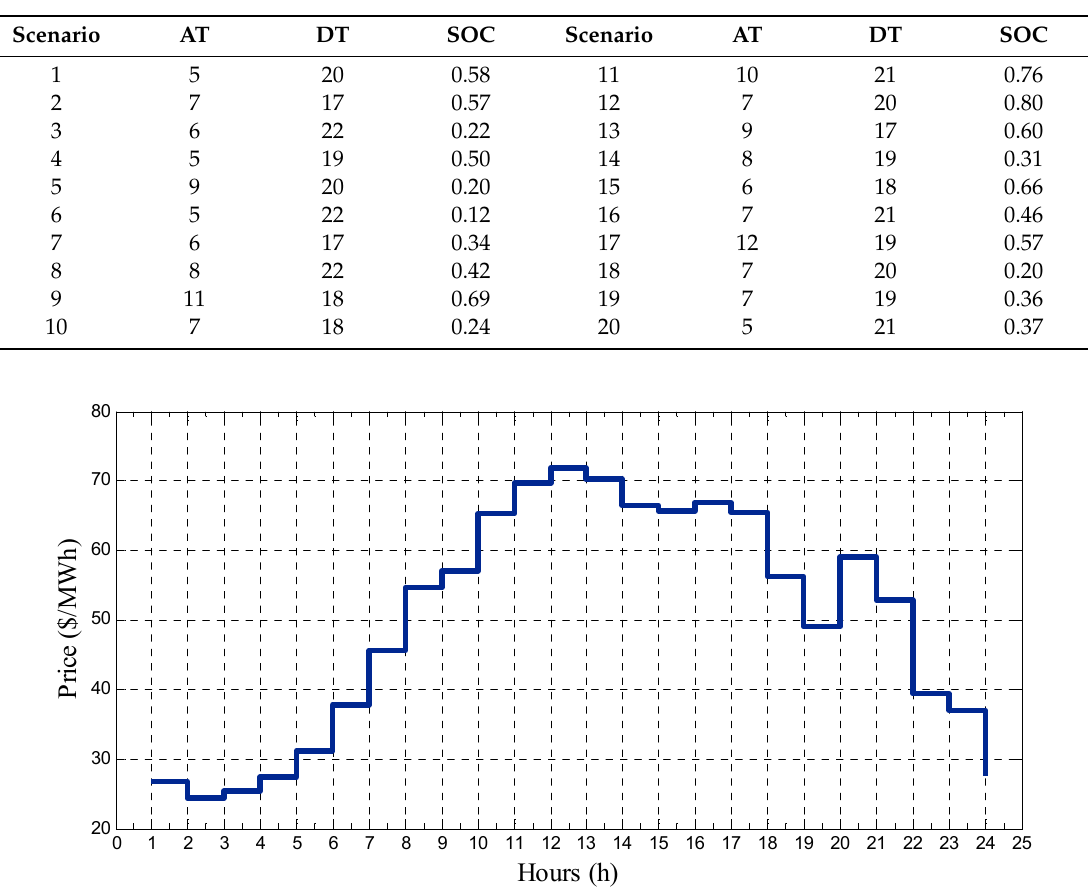
Figure 2. Electricity price profile.